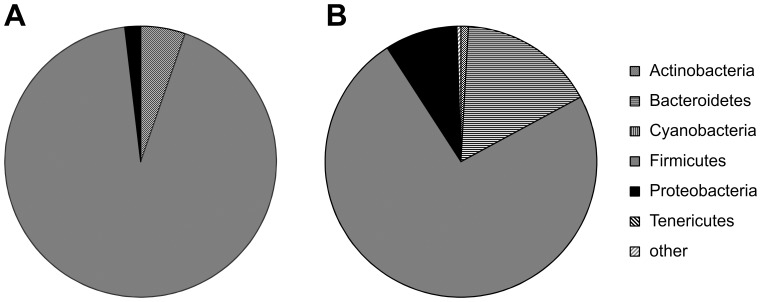
Differences in the proportions of prevalent bacterial phyla, based on 454 16S rRNA sequencing, in controls at week 0 in A) Jacksonville and B) Gainesville.